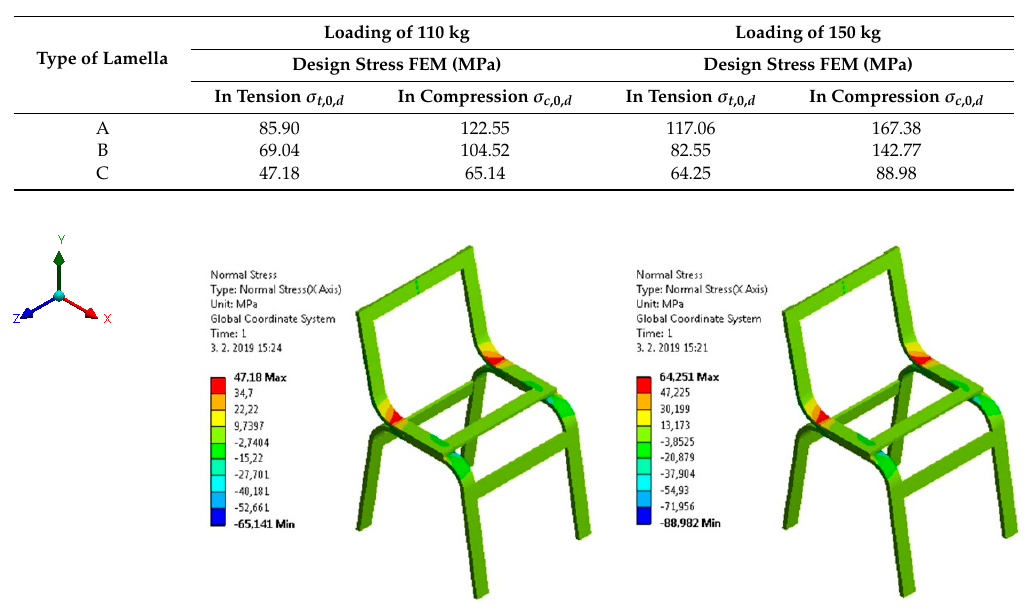
Figure 6. FEM visual outputs and stress concentration in tension and compression parts of lumbar curve of chair. Left for 110 kg tension (max. 47.18 MPa) and compression (max. 65.14 MPa) design stress and right for 150 kg tension (max. 64.25 MPa) and compression (max. 88.98 MPa).